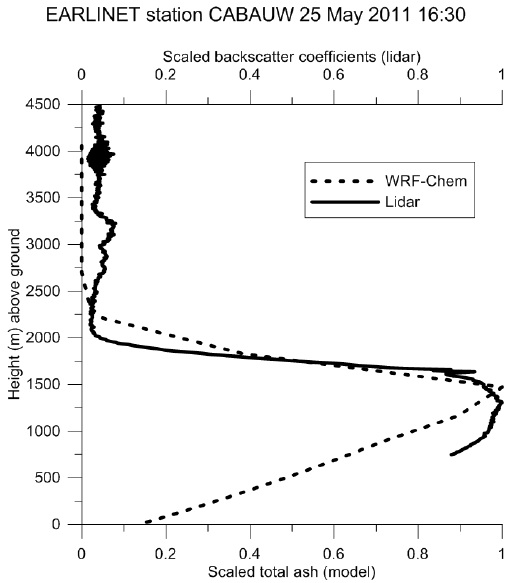
Figure 11. Vertical (scaled) profiles of WRF-Chem S3-based total ash and backscattering coefficients from the EARLINET lidar at Cabauw on 25 May 2011,